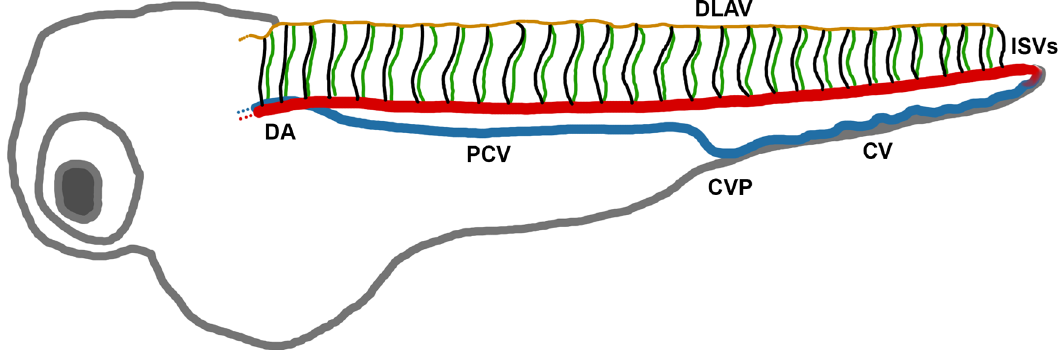
Figure1.Diagramofthezebrafishvasculatureat72hpf. DA – dorsalaorta.DLAV-dorsallongitudinalanastomotic vessel. CV - caudal vein. CVP - caudal vein plexus. PCV - posterior cardinal vein. ISVs - intersegmental